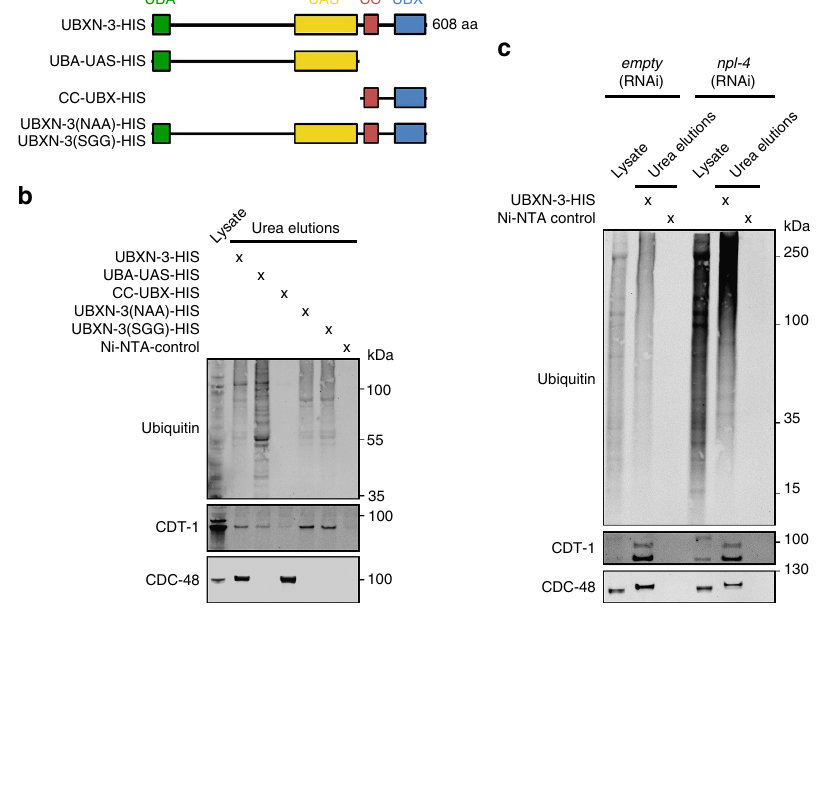
NATURE COMMUNICATIONS|7:11593|DOI: